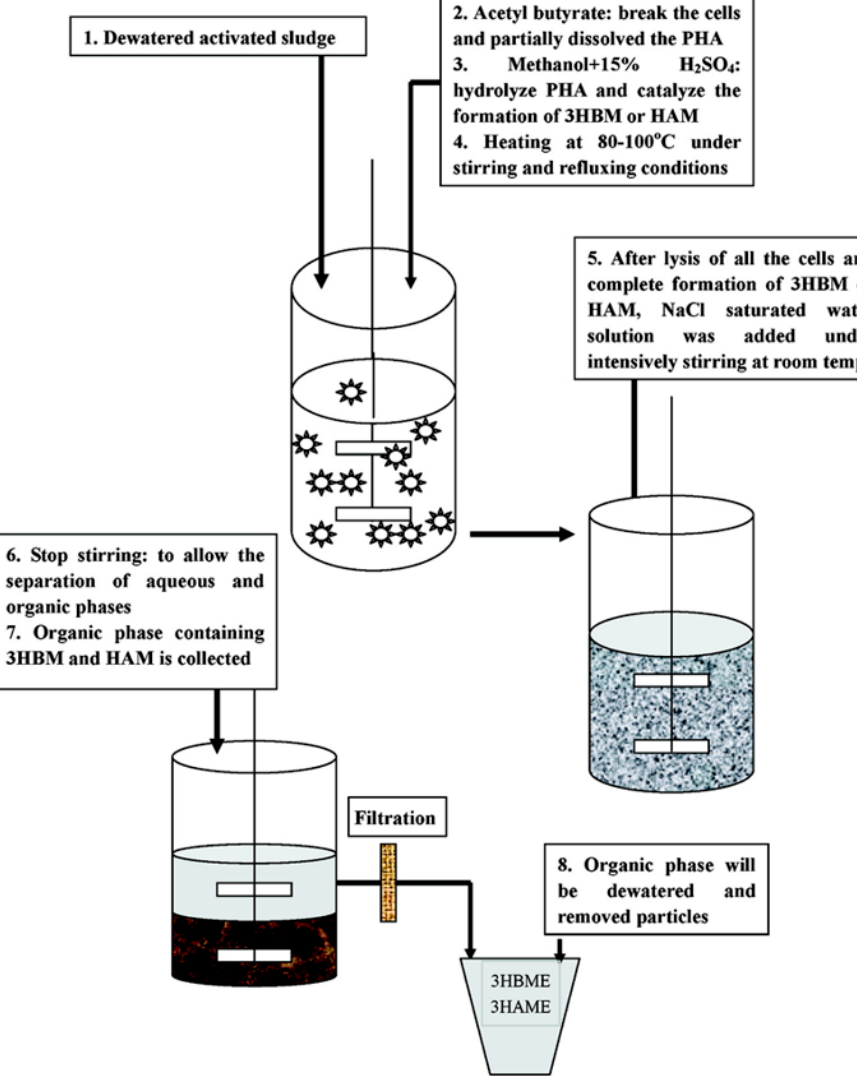
Figure 7. Production of PHA based biofuels hydroxyalkanoates methyl ester (HAME) or hydroxybutyrate methyl ester (HBME). Reproduced with permission from [122]. Copyright 2009 American Chemical